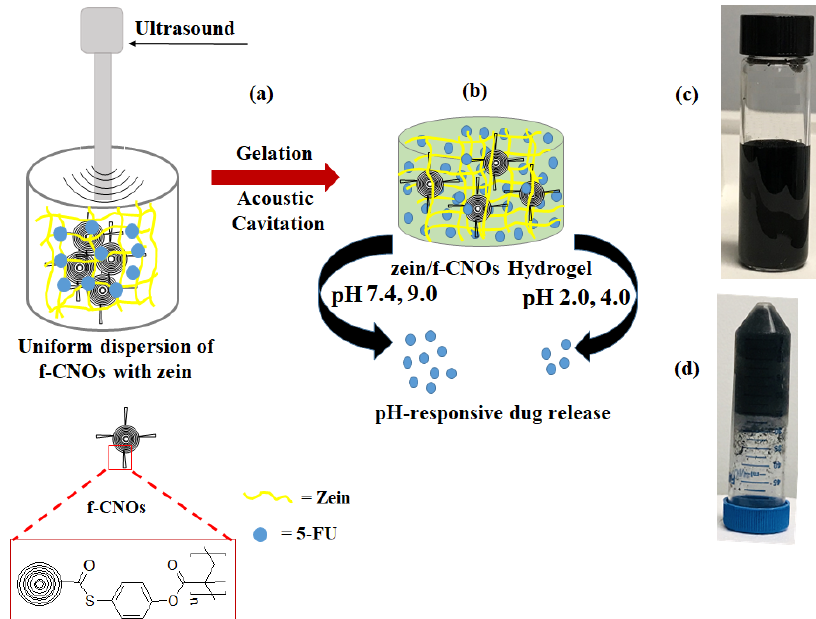
Figure 1. Synthetic illustration of ( a ) hydrogel preparation via acoustic cavitation, ( b ) cartoon diagram of hydrogel, ( c ) digital photograph of uniformly dispersed f-CNOs in DMEM after 1 year, and ( d ) digital photographs of fabricated UZCNOs hydrogel composite. f-CNOs indicates functionalized CNOs.